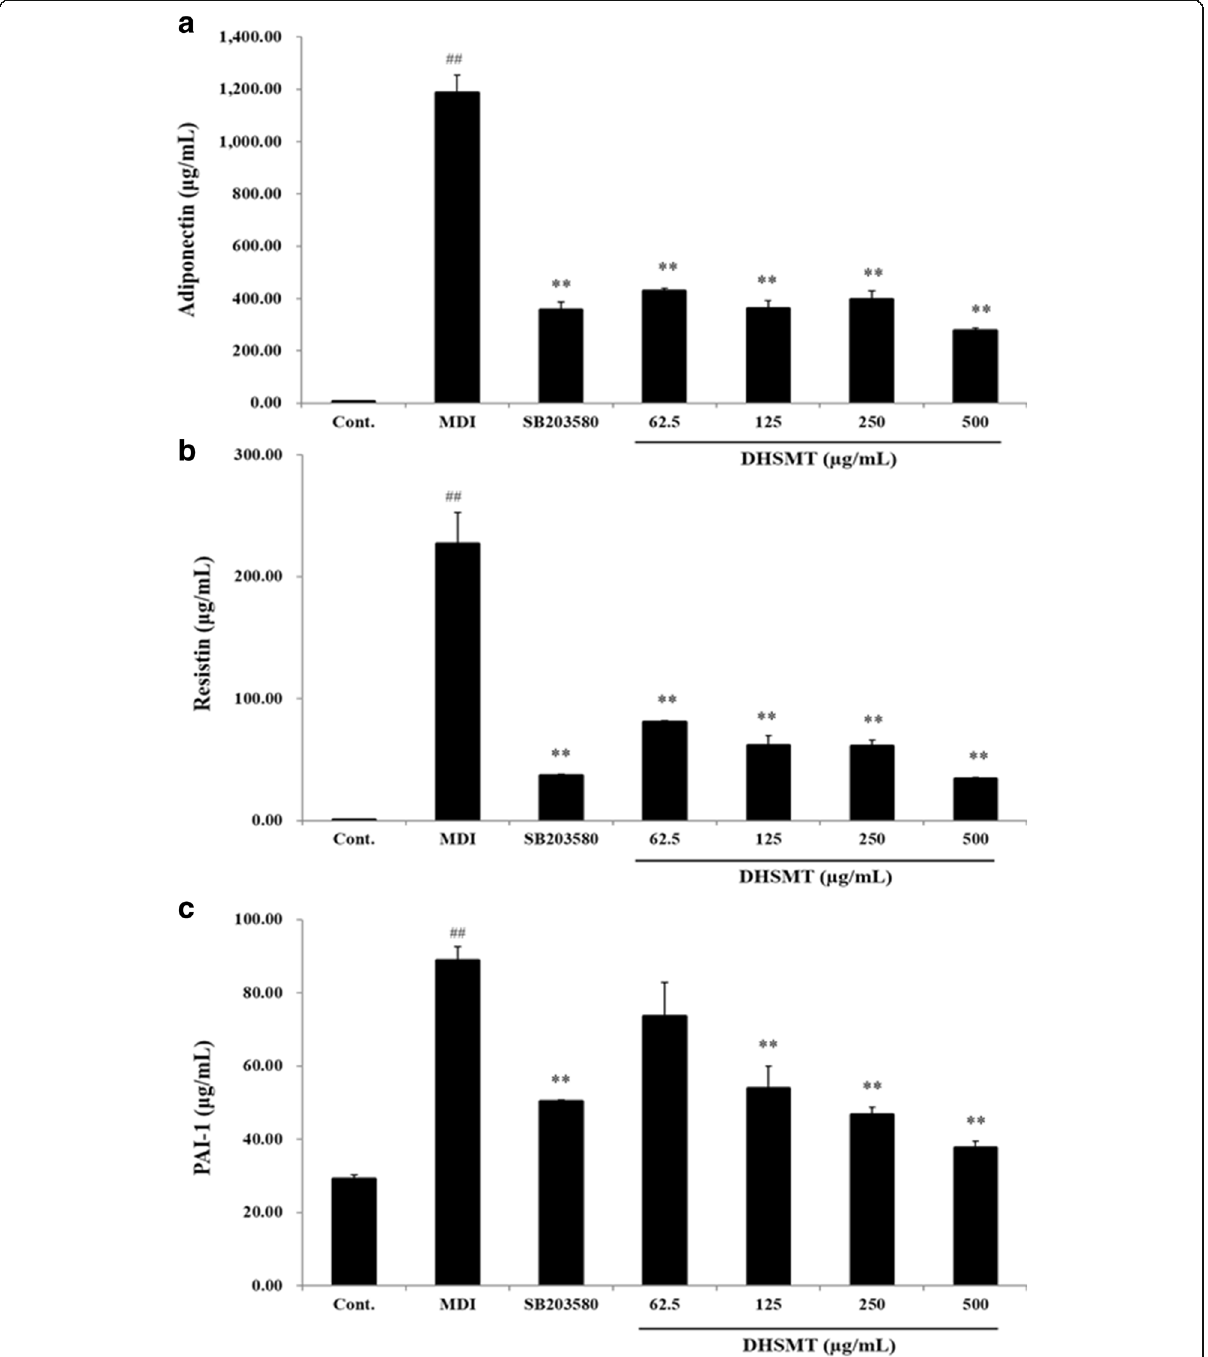
Fig. 5 Inhibitory effect of DHSMT on adipokines accumulation in 3T3-L1 adipocytes. 3T3-L1 preadipocytes were differentiated into adipocytes by various concentrations of DHSMT (0, 62.5, 125, 250 and 500 μ g/ml) and SB203580 with a mixture of 3-isobutyl-1-methylisobutylxanthine, dexamethasone and insulin (MDI) for 7 days. Adiponectin ( a ), resistin ( b ) and PAI-1( c ) production were measured by a Milliplex ® MAP mouse adipocyte magnetic bead panel kit (Millipore Co. USA). The data are mean values of three experiments ± SEM; ## < 0.01 compared with control, * P < 0.05; ** P < 0.01 compared with the